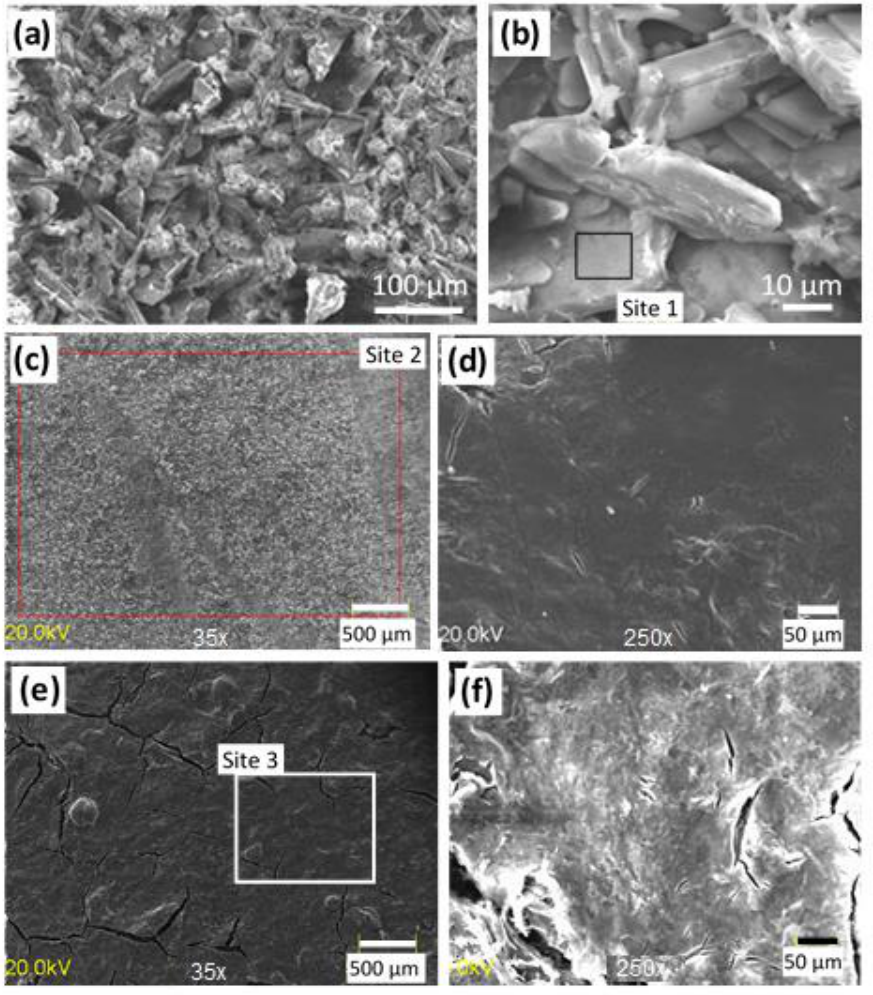
Figure 2. SEM images of ( a , b ) Ca-P ( c , d ) Ca-P/chitosan_WG and ( e , f ) chitosan_WG coatings deposited on the Mg20Zn alloy.